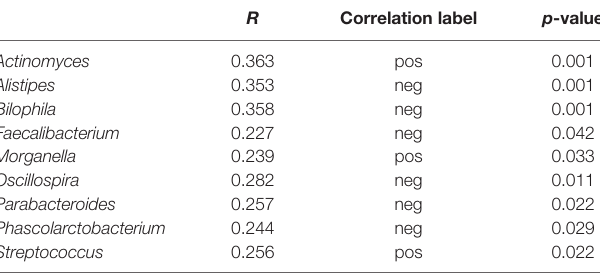
TABLE 2 | Spearman ’ s correlation table on OTUs and serum uric acid level. R Correlation label p -value